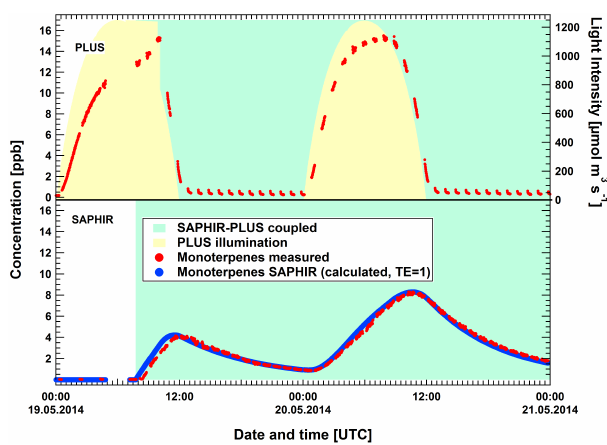
Figure 4. Measured/calculated averaged mixing ratios of VOC gas standard compounds. Upper panel shows the transfer efficiency be- tween the PLUS inlet and PLUS outlet. Lower panel shows the transfer efficiency between the PLUS outlet and the SAPHIR cham- ber. Error bars shown are the standard deviation ( N PLUS = 18, N SAPHIR = 37).